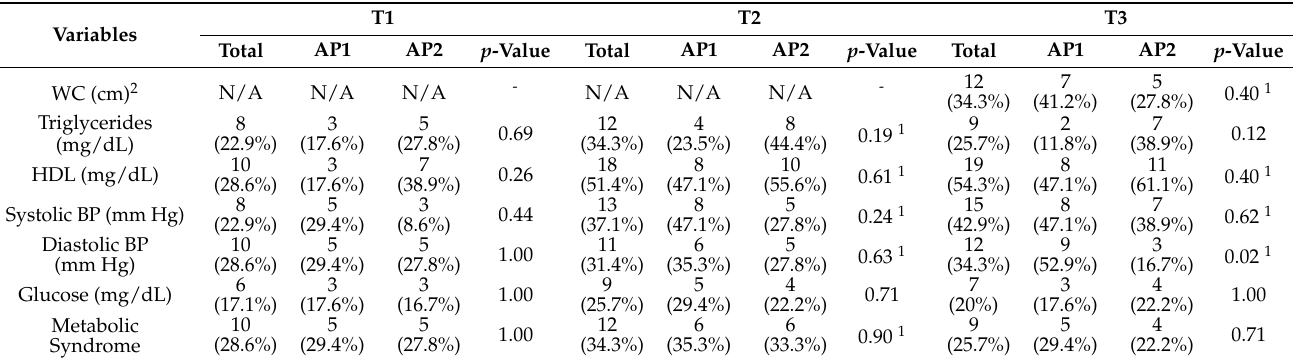
Table 4. Independence tests for the presence of metabolic syndrome in subgroups of forensic psychiatric patients receiving antipsychotic medication AP1 and AP2, at the three yearly time points (2018, 2019, 2020).